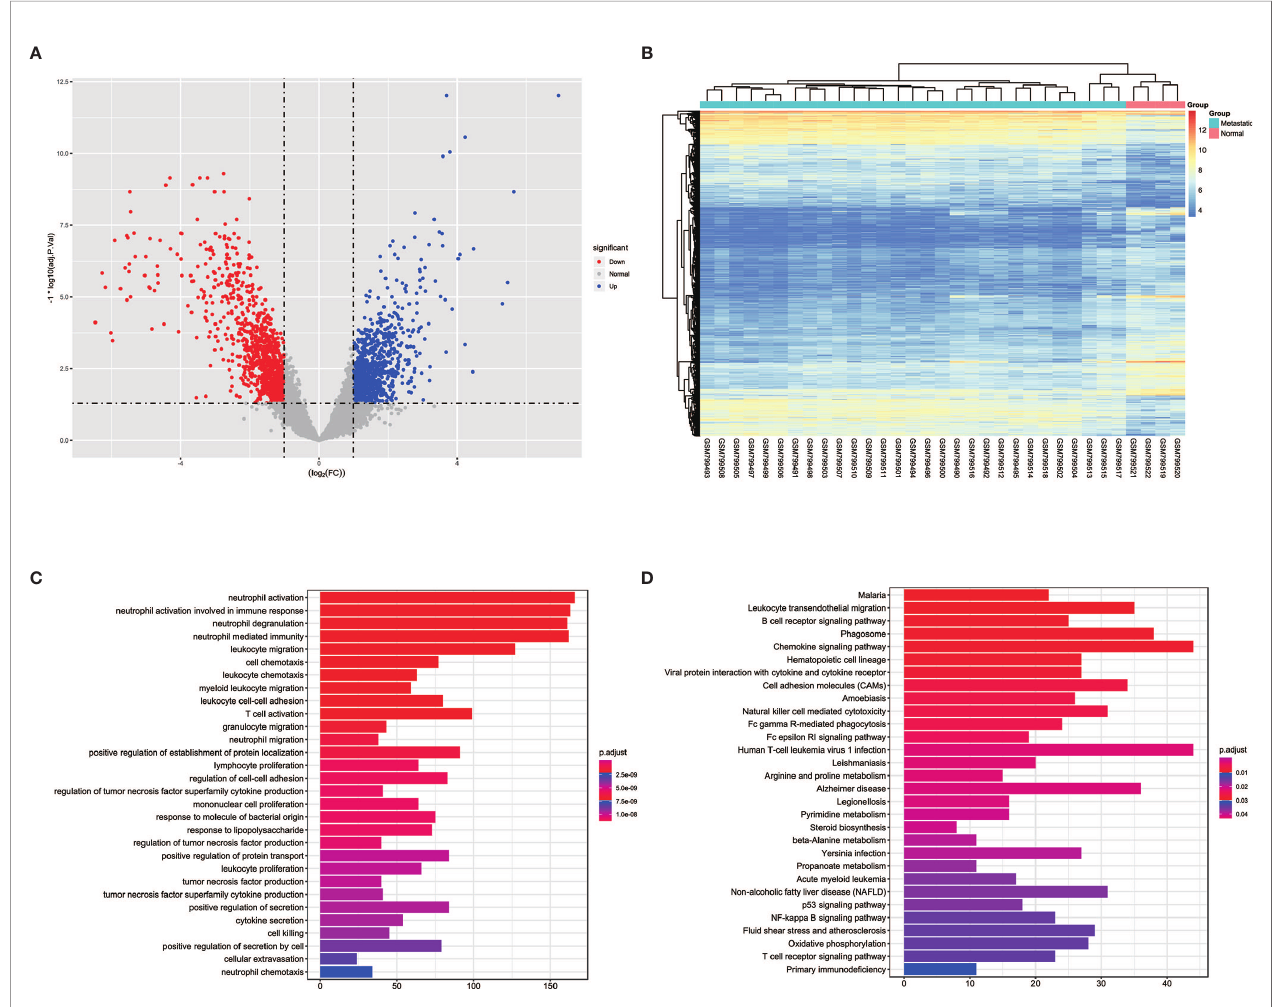
FIGURE 1 | The volcano, heatmap, GO and KEGG enrichment results of differentially expressed genes (DEGs) between tumor and normal cells in bone. (A) The volcano plot for DEGs. Grey dots represent genes which are not differentially expressed, red dots represent the upregulated genes, and the blue dots represent the downregulated genes. (B) The heatmap for DEGs. (C) The annotation of gene ontology function of DEGs using GO enrichment analysis. (D) The annotation of pathway function of DEGs using KEGG enrichment analysis.